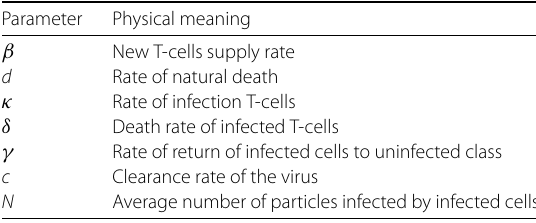
Table 1 Physical meaning of the parameters in the continuous model (1) Parameter Physical meaning β